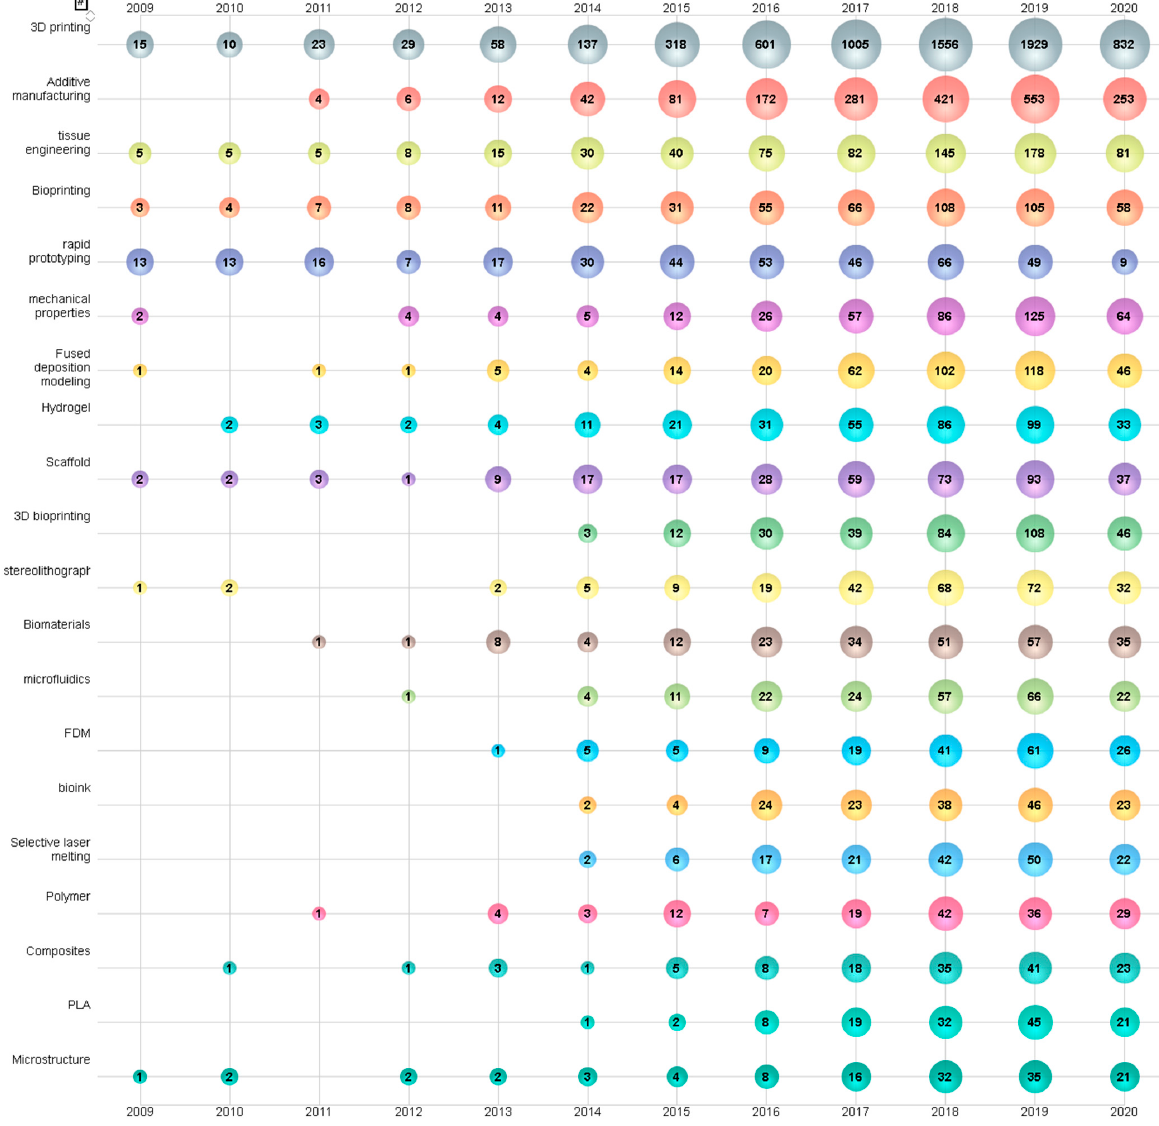
Figure 4. Collaboration matrix map among the top 10 productive countries. 3.2. Contribution of Leading Institutions Table 2 lists the top 10 institutions in the 3D printing field, ranked by their number of publications, citations and h -index. The Chinese Academy of Sciences contributes the most publications among all institutions, followed by Nanyang Technological University and Tsinghua University. As for the ACPP and h -indexes, Harvard University has the highest ACPP (77.99) and highest h -indexes (61), followed by the Massachusetts Institute of Technology (MIT) with ACPP 40.23 and h -indexes 51. Nanyang Technological Univer- sity has the third highest ACPP (29.94). Clearly, these institutions play key roles in the development and promotion of this field. Although there are five Chinese institutions on the top 10 list, their ACPP and TPR results are relatively low. As shown in Figure 5, alt- hough the Chinese Academy of Sciences published the largest number of articles, their collaborations intensity is relatively low compared with Harvard University. Most collab- orations are concentrated on domestic institutions, such as Harvard University with MIT,